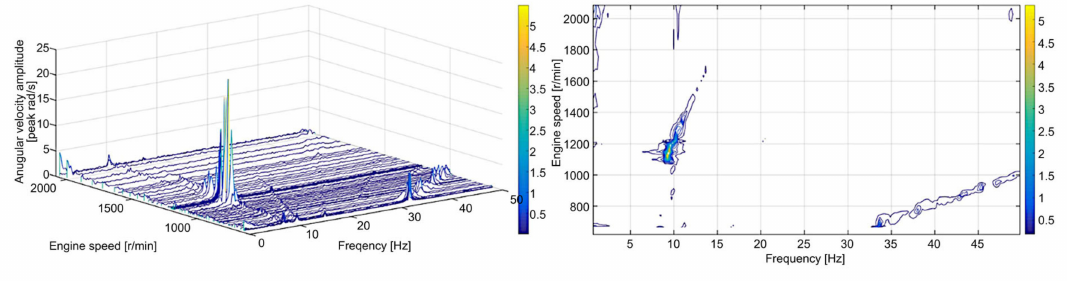
Figure 10. Frequency domain of angular velocity on engine side of flexible coupling during